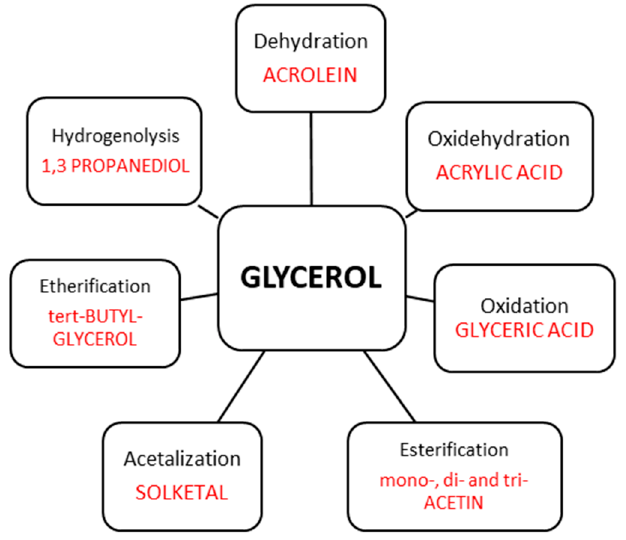
Figure 20. Transformation of glycerol in catalytic reactions performed on niobium-containing cata-